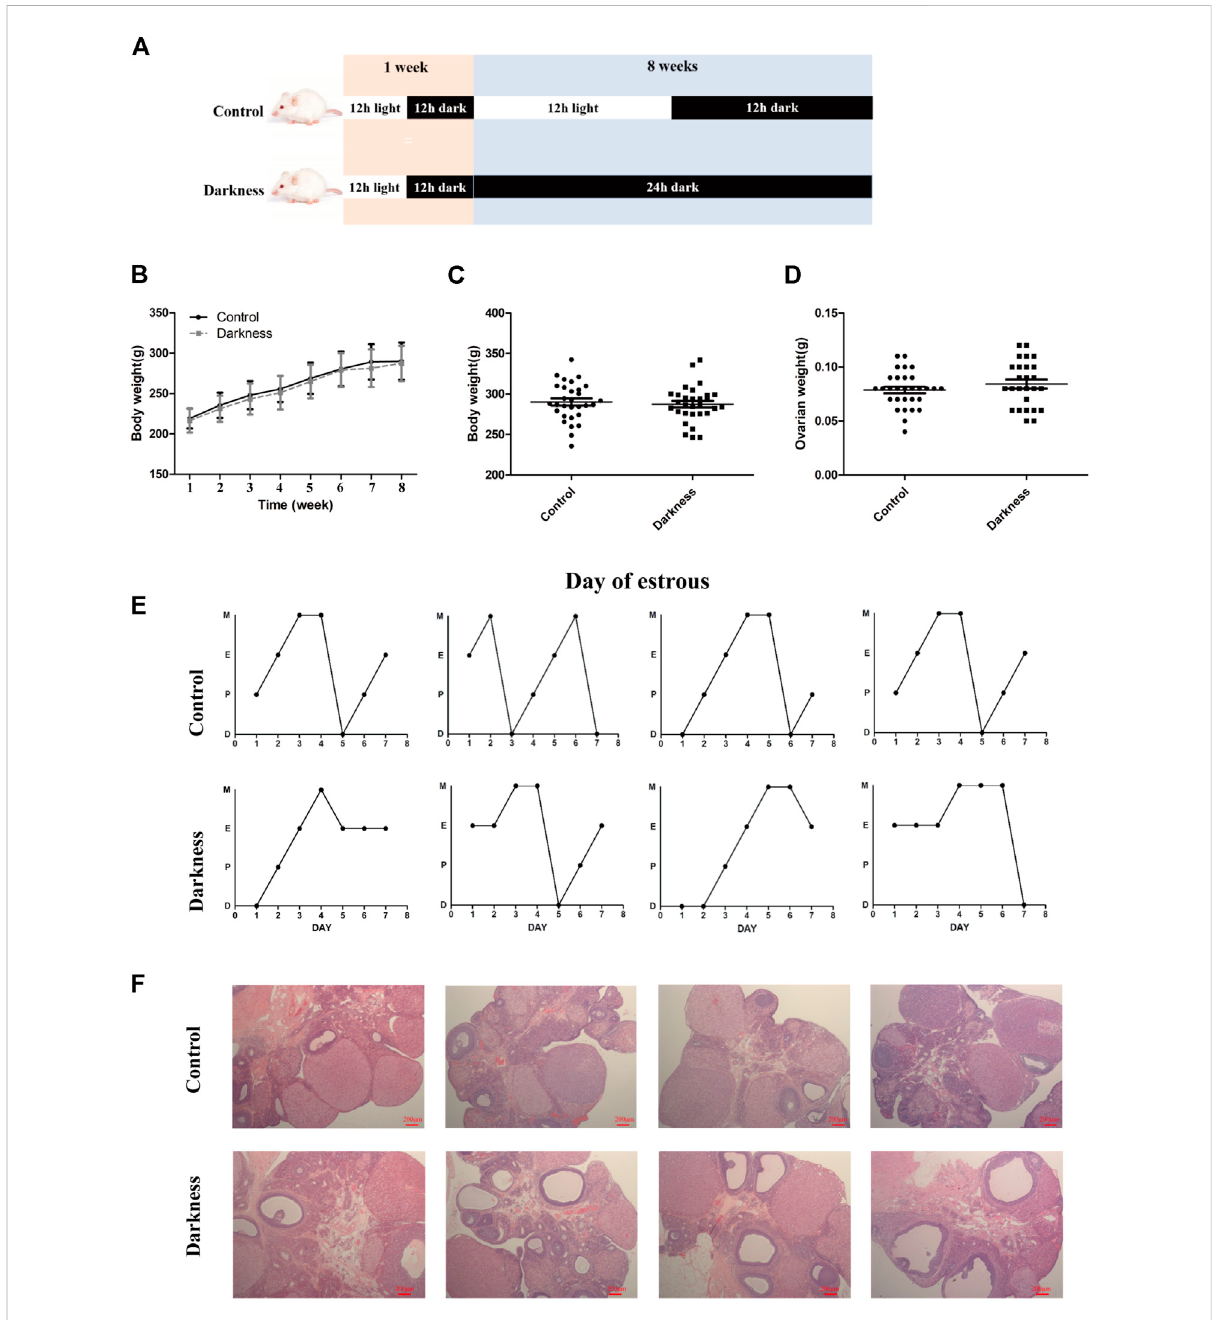
FIGURE 1 Long-term continuous darkness leads to estrous cycledisorder and polycystic ovary inrats. (A) Diagram of theexperimentaldesign. (B,C) Body weight of two groups of rats. (D) Ovarian weight of each group of rats. (E) Representative estrous cycles of two groups. The upper and lower panels representthecontrolanddarknessgroups,respectively. D,diestrus;P,proestrus;E,estrus;M,metestrus. (F) RepresentativeexamplesofovarianHE- stain histology of two groups. The upper and lower panels represent the control and darkness groups, respectively. N = 30/group. Values are expressed as means ± SEM. Scale bar: 200 μ